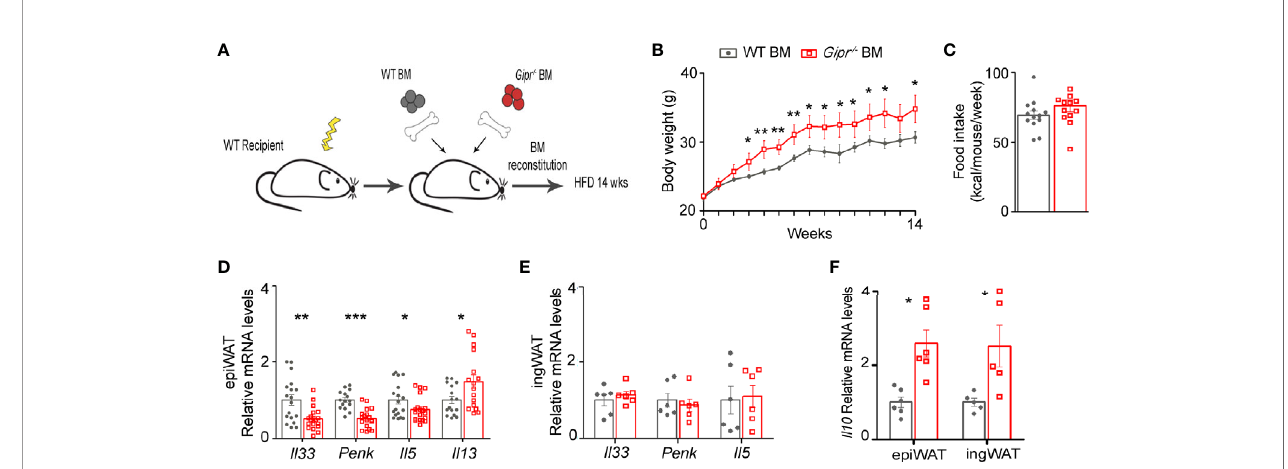
FIGURE 1 | Impaired production of type 2 immune mediators in the obese epiWAT of Gipr -/- BM mice. (A) Scheme illustrating experimental design. Lethally irradiated WT mice were reconstituted by transplantation of WT BM (gray circles) or Gipr -/- BM (red squares) for 6 weeks and then fed a HFD for 14 weeks. (B) Weekly measurements of body weight (g) (n ≥ 6). (C) Average weekly food consumption (kcal) per mouse during a period of 14 weeks. (D – E) Expression of key type 2 immune mediators in (D) epiWAT (n ≥ 17) and (E) ingWAT (n=6) after 14 weeks of HFD, as analyzed by qRT-PCR and normalized to Rplp0 . (F) Relative expression of Il10 in epiWAT and ingWAT as determined by qRT-PCR. Data is compiled from three individual experiments (D) or from single individual experiment (B, C, E, F), and presented as mean ± SEM with signi fi cance: *p ≤ 0.05, **p ≤ 0.01, and ***p ≤ 0.001, unpaired two-tailed t -test, comparing between WT BM and Gipr -/- BM groups. WT, wild type mice; BM, bone marrow; HFD, high-fat diet; epiWAT, epididymal WAT; ingWAT, subcutaneous inguinal